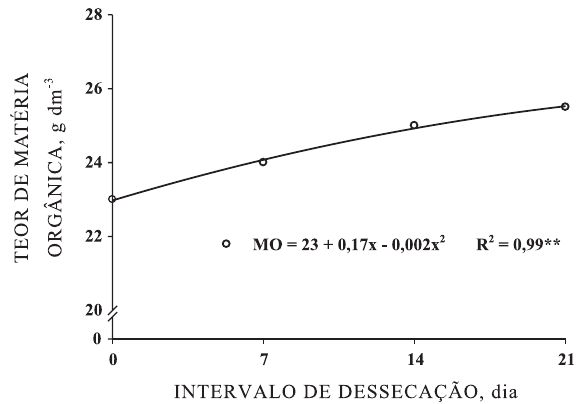
Figura 3. Teor médio de matéria orgânica no solo para as três espécies de plantas de cobertura, em função do intervalo de dessecação.